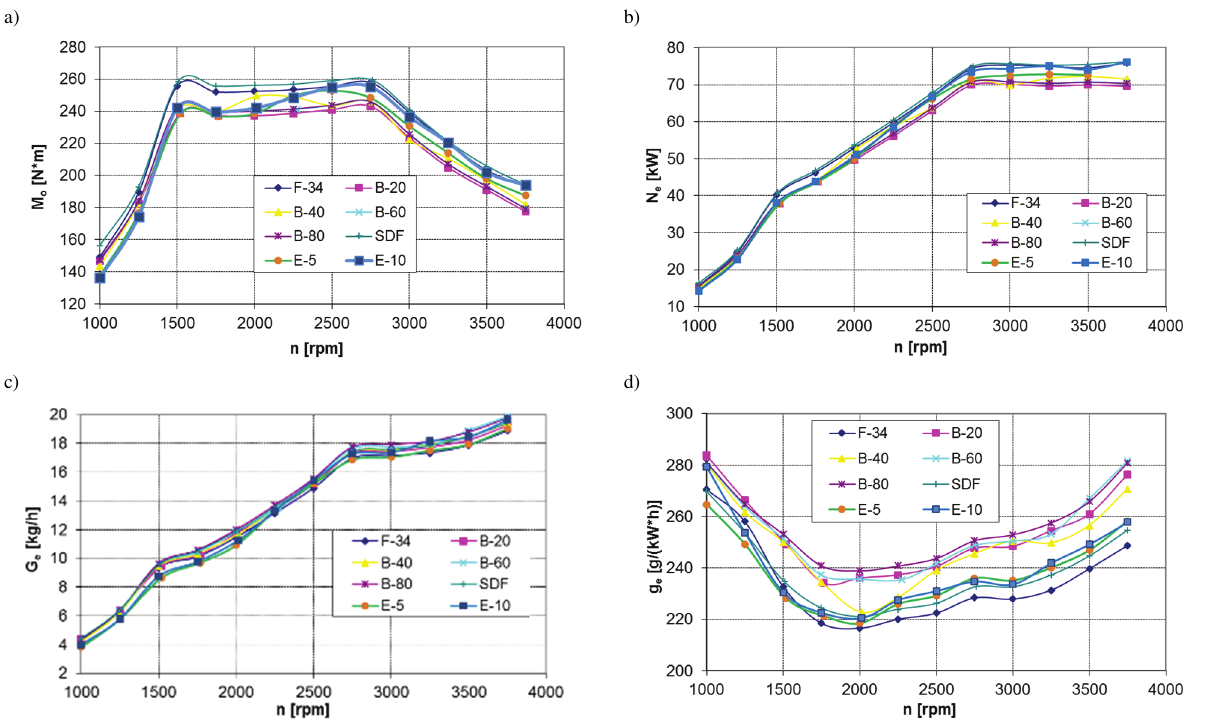
Fig. 1. External characteristic of the engine: a) torque, b) effective power, c) fuel consumption, d) specific fuel